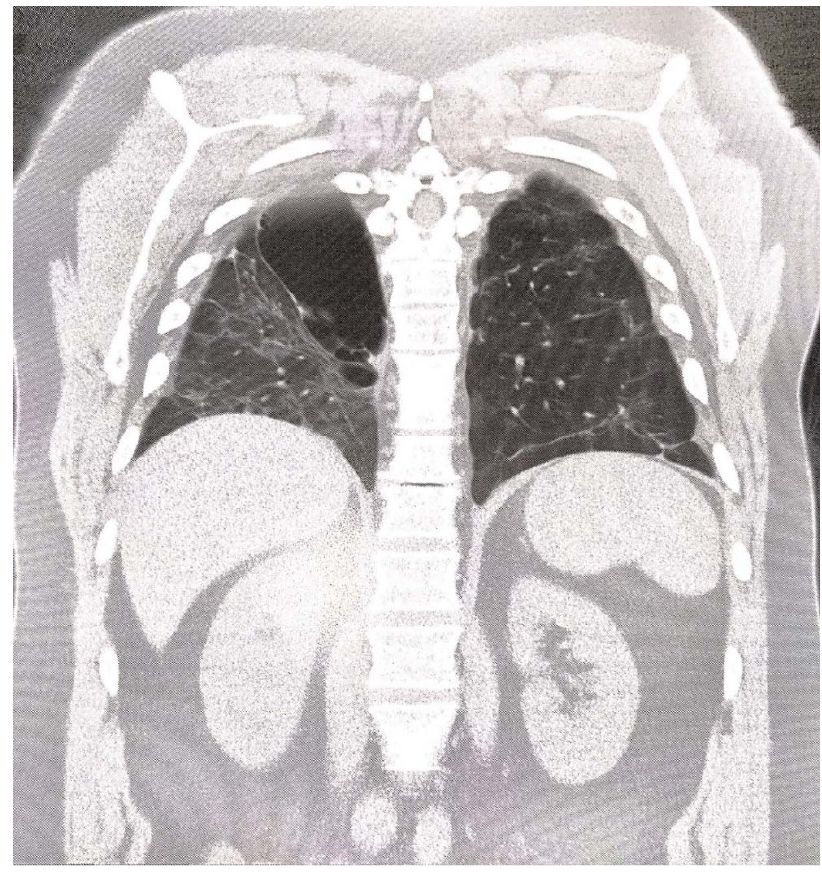
Figure 2. CT chest—showing pneumothorax on the right side.